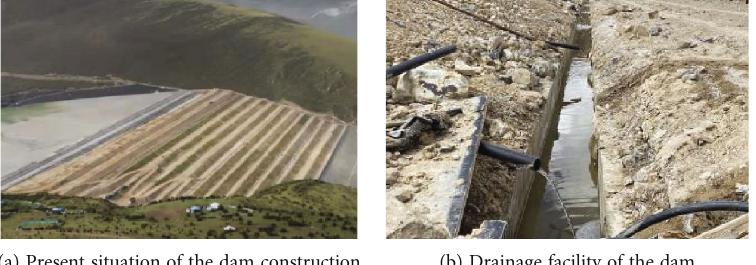
Figure 7: Field dam construction.